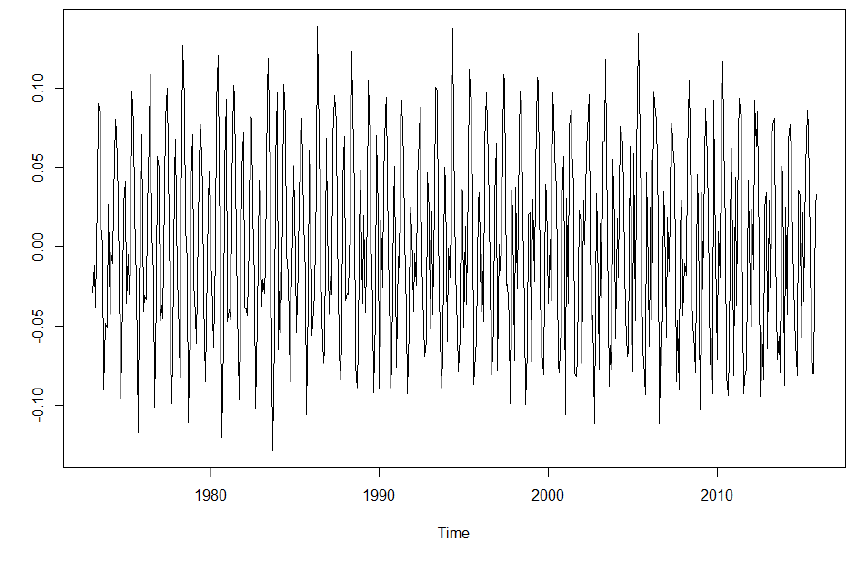
Figure 3. The differenced log (electricity data) from January 1973 to January